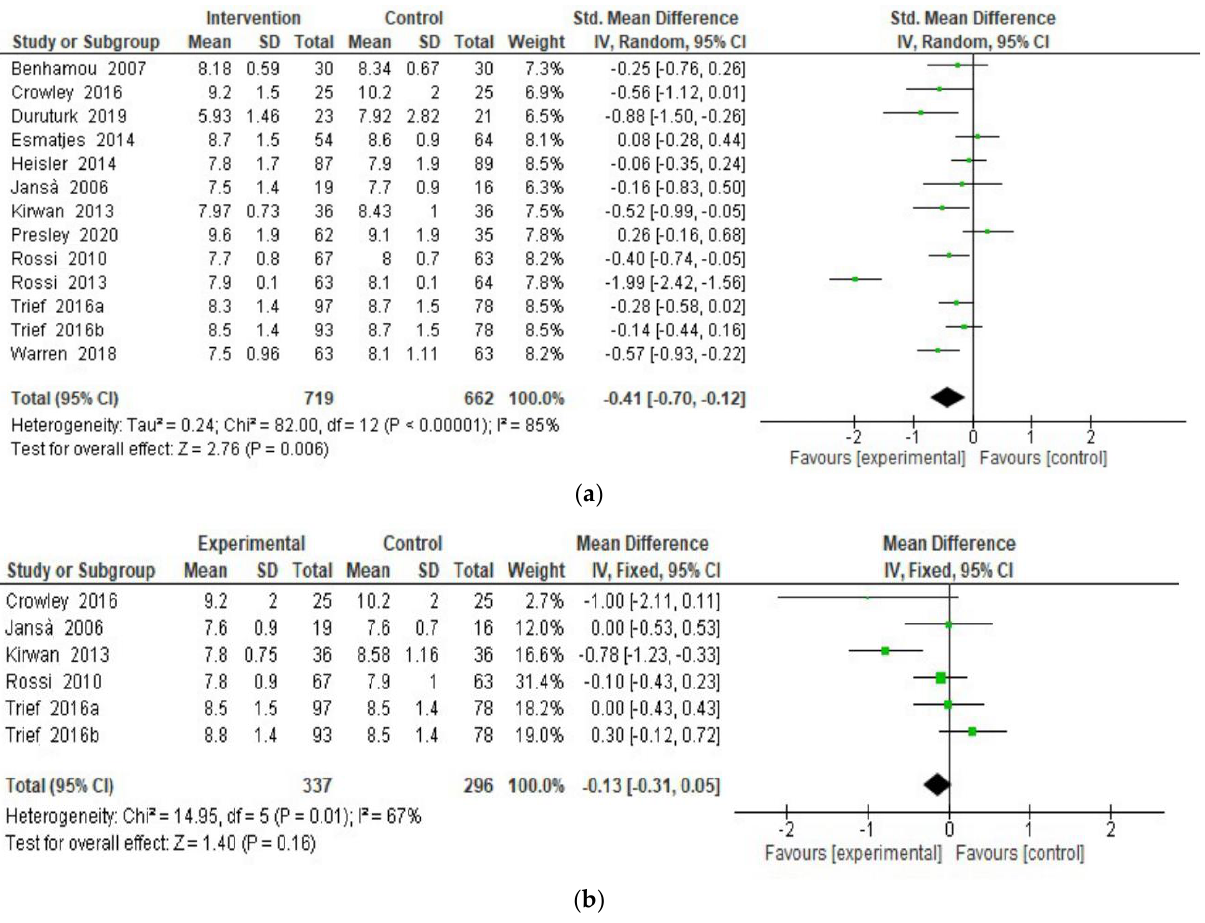
Figure 3. ( a ) . HbA1c at endpoint. ( b ). HbA1c at follow-up. Table 3. Sub-group and meta-regression analyses.